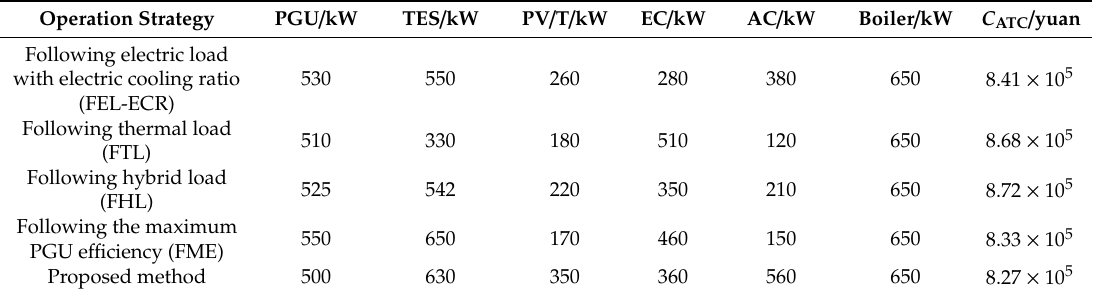
Table 5. Optimum configuration of the CCHP system under di ff erent operation strategies.